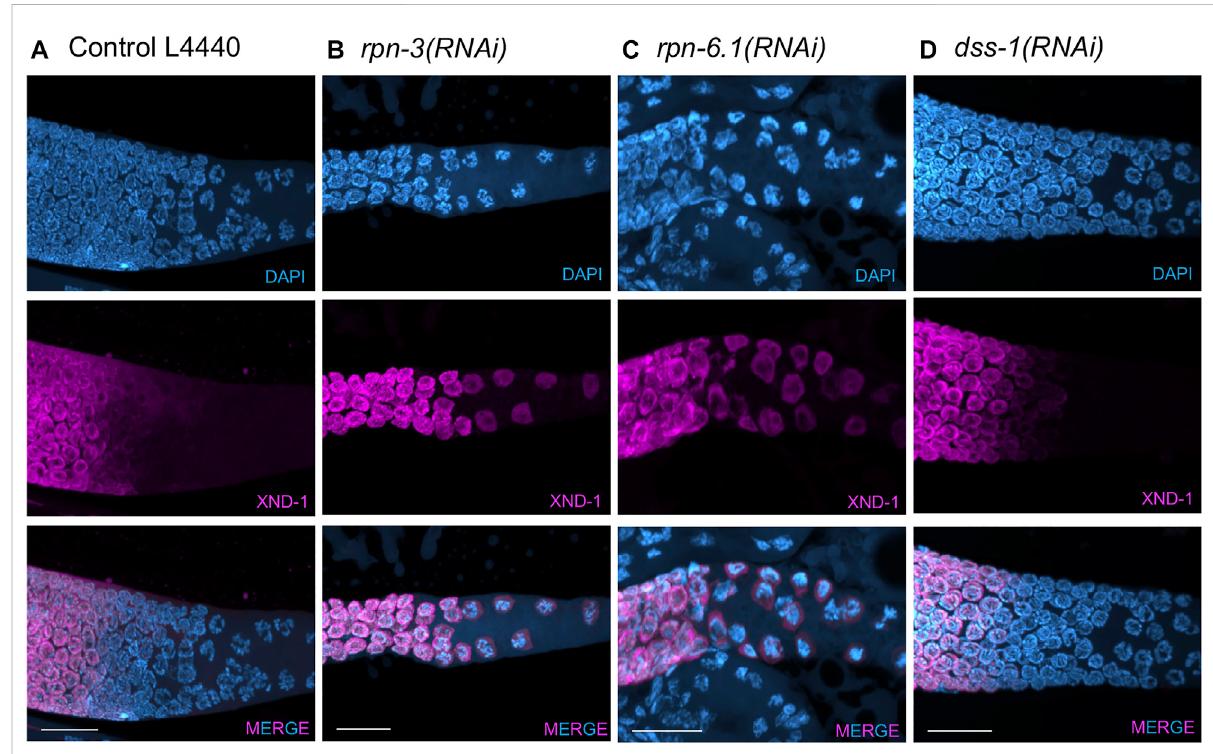
FIGURE 5 XND-1 turnover is affected by knockdown of a subset of 19S RP non-ATPase subunits. Representative images showing defects in XND-1 turnoverafterdepletionofaspeci fi cgroupofnon-ATPaseproteasomesubunits.Anti-XND-1(magenta);DAPIstainedDNA(cyan). (A) Vectorcontrol. (B) rpn-3(RNAi) , and (C) rpn-6.1(RNAi) are examples of two subunits whose knockdown causes persistence of high levels of nucleoplasmic XND-1 in late pachytene nuclei. (D) dss-1(RNAi) is representative of the class of subunits who depletion does not affect XND-1. Scale bar, 50